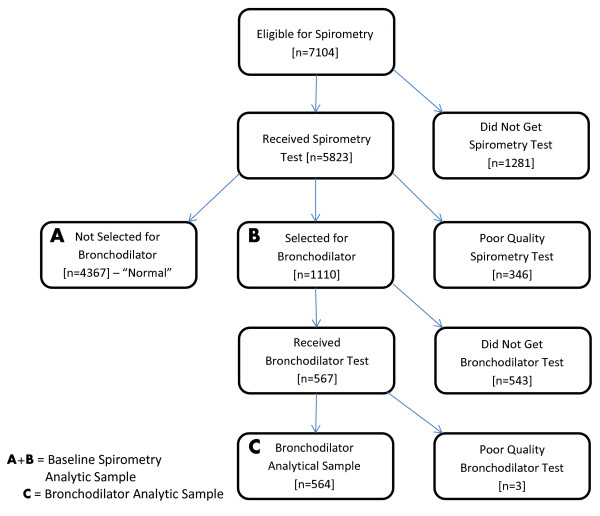
Flow diagram of the study population.